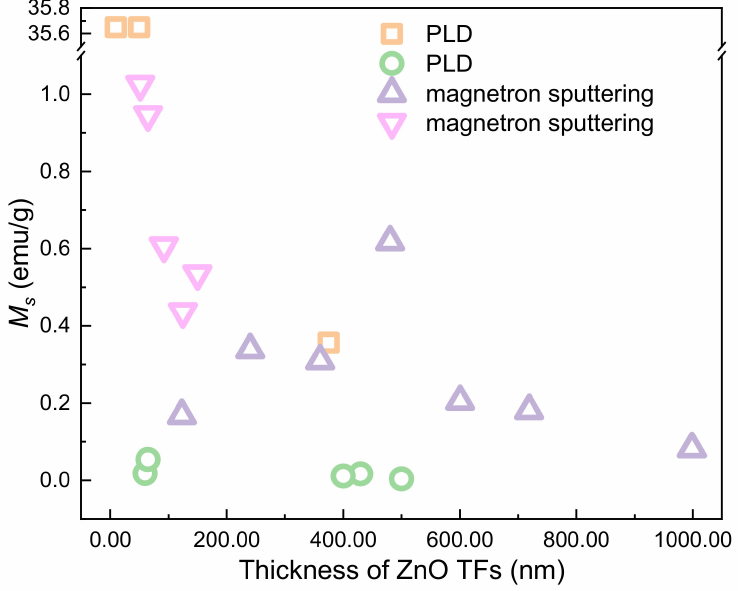
Figure 11. The thickness-dependent RTFM in ZnO